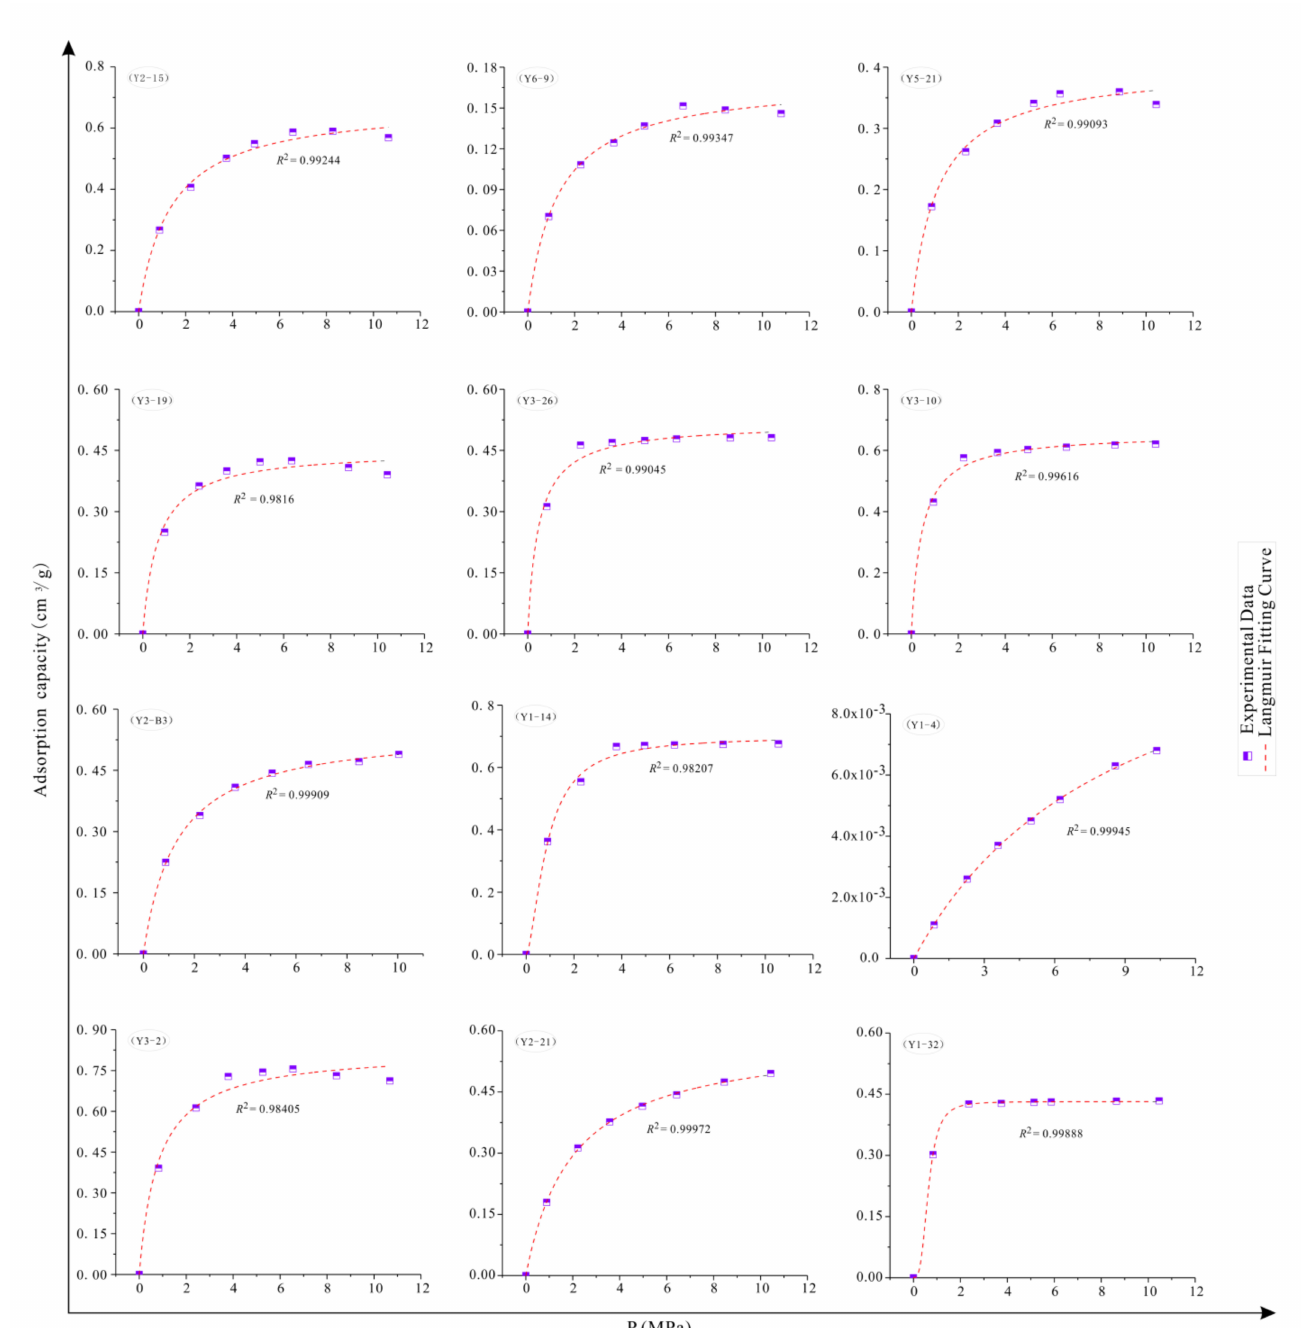
Figure 3. The experimental data of CH 4 adsorption isotherm and the Langmuir model fitting